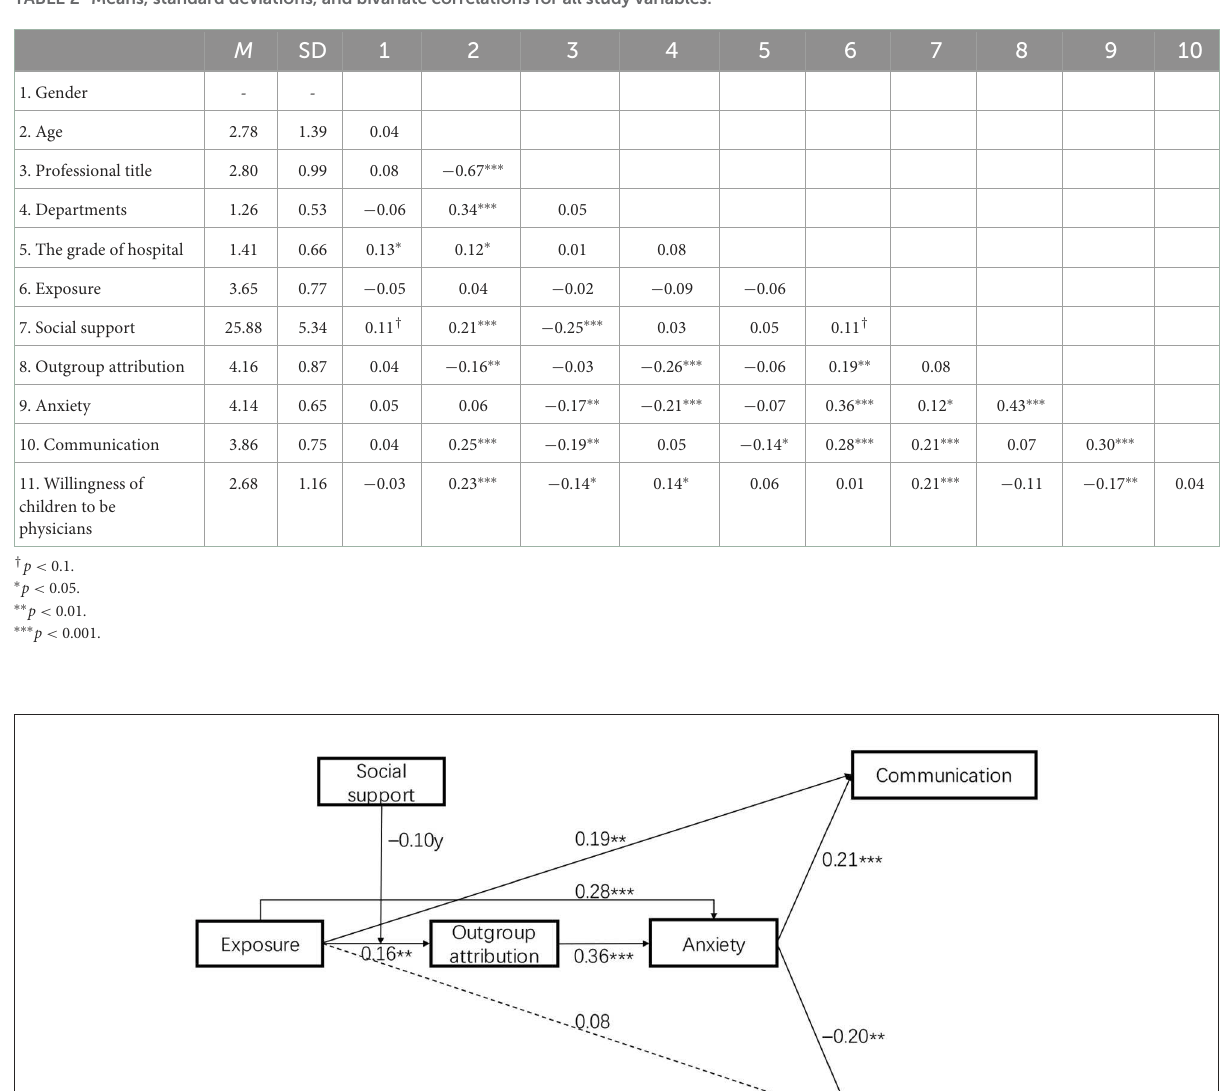
TABLE 2 Means, standard deviations, and bivariate correlations for all study variables.